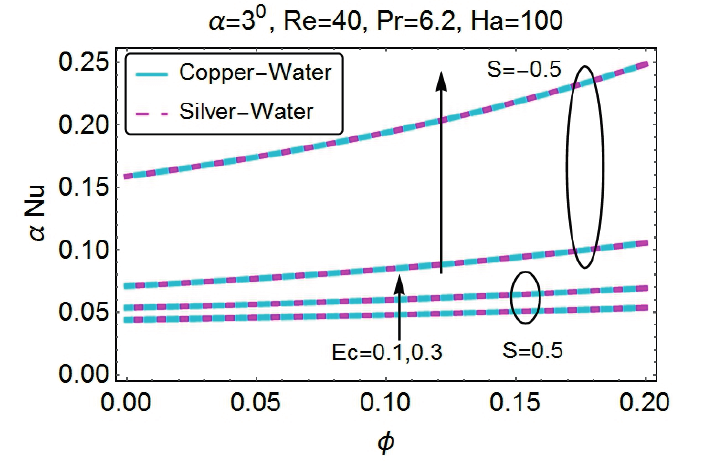
Figure 34. Variation in the Nusselt number with the Eckert number and the nanoparticle volume fraction (divergent channel).